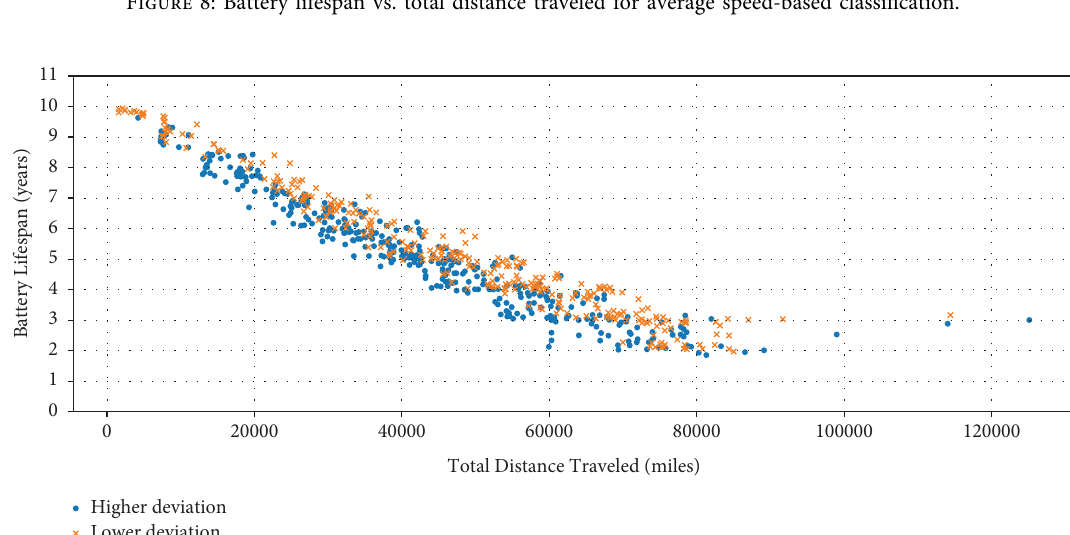
Figure 9: Battery lifespan vs. total distance traveled for speed deviation-based